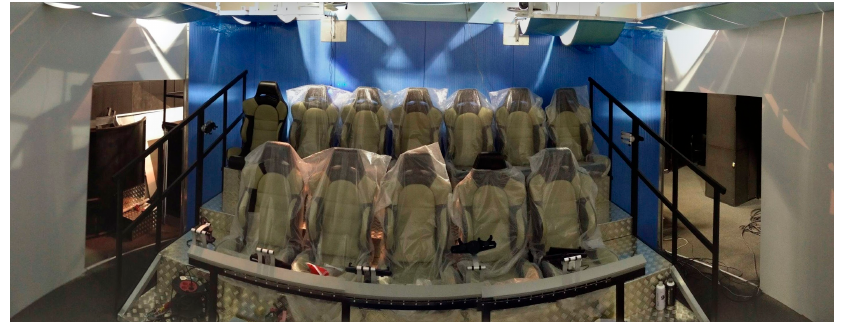
Figure 1. Panoramic image of the robotized house.